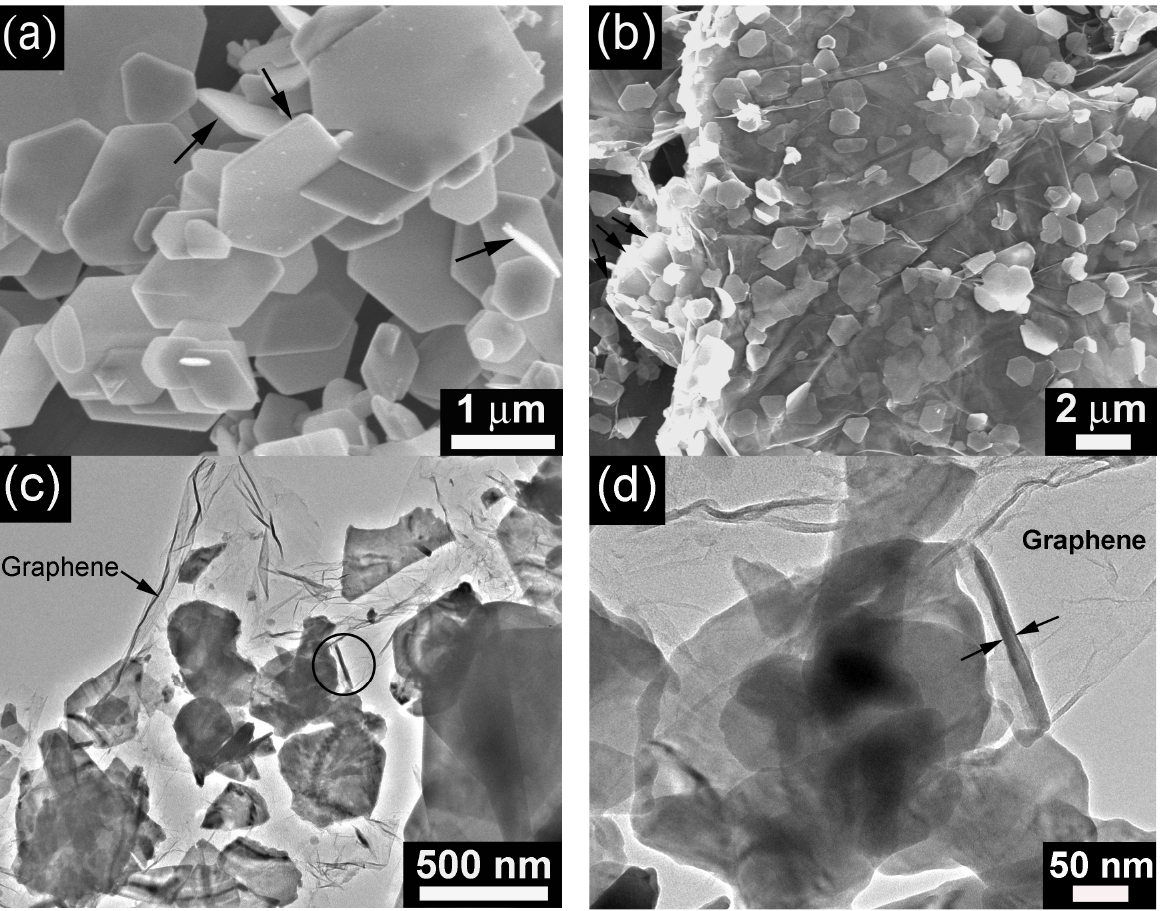
Figure 2. ( a ) SEM image of bare Bi image of Bi Te /G hybrid; ( d ) the enlarged view of the circled part in ( c 2 3